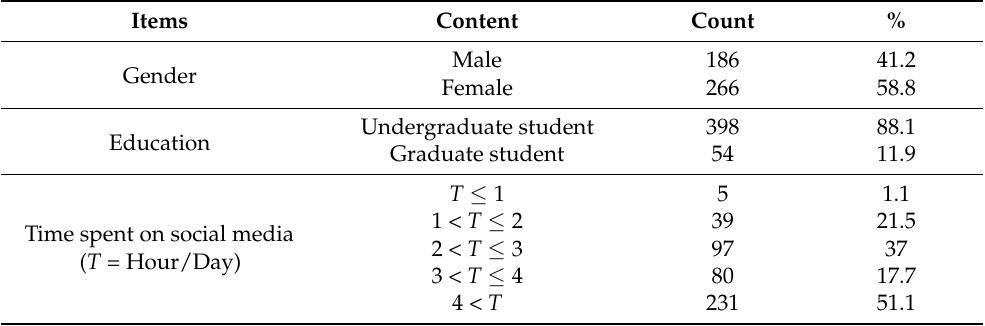
Table 2. Demographic profile of participants ( n =